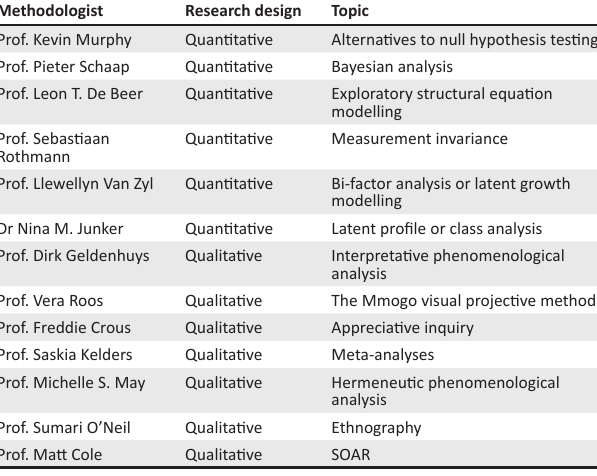
TABLE 3: Suggestions for step-by-step guidelines and possible